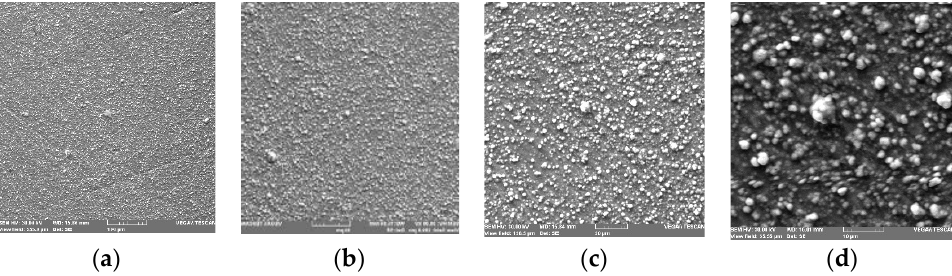
Figure 13. Microstructures of the ionic nitrided structure with the polarized screen—the 30° edge area at the top of the prismatic section and a distance of 40 mm from the base of the part. SEM images at different magnifications: ( a ) 500×, ( b ) 1000×, ( c ) 2000×, and ( d ) 5000×.